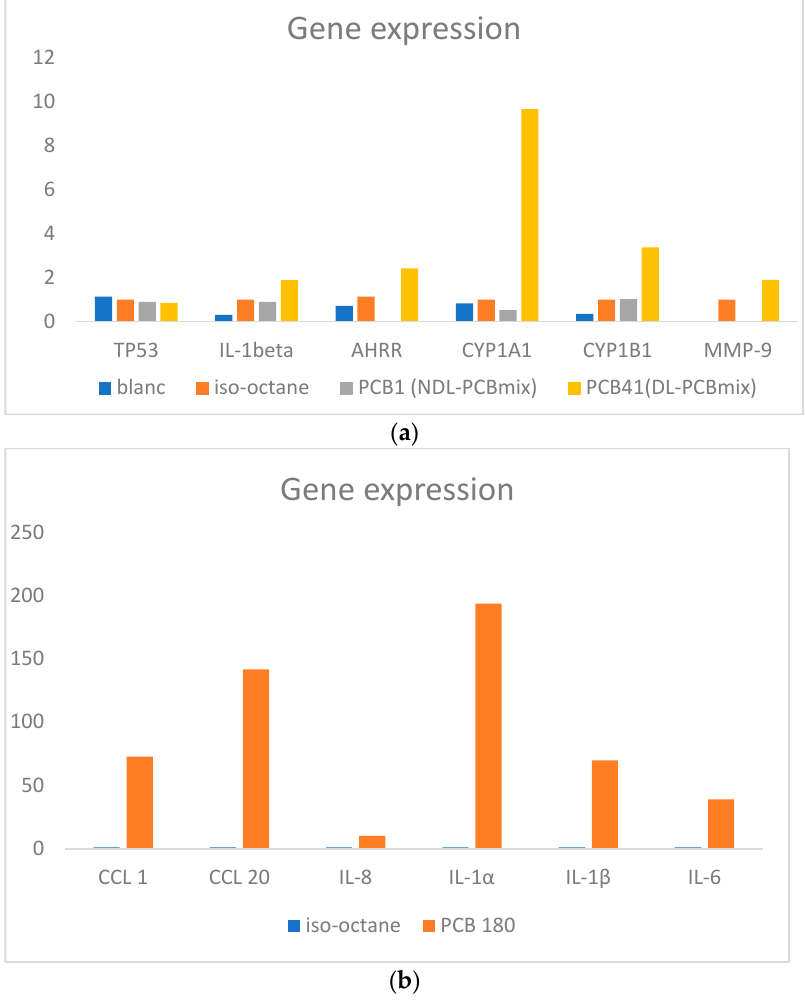
Figure 1. Differently regulated genes confirmed by RT-PCR: Some differently regulated genes of interest were confirmed by qRT-PCR. In the figure, their relative quantitation compared to the vehicle (iso-octane) is displayed. ( a ) shows the confirmed genes for non-dioxin-like (NDL)-PCB mix1 and dioxin-like (DL)-PCB mix41. The tumor suppressor gene (TP53) showed a slight downregulation for the DL and NDL-mixture; CYP1A1, CYP1B1, AHRR and MMP-9 were upregulated by the DL-PCBmix. ( b ) displays confirmed upregulated genes for PCB 180: CCL 1, CCL 20, IL1- α , IL1- β , IL-6. Other confirmed genes are listed in the Supplementary Materials.